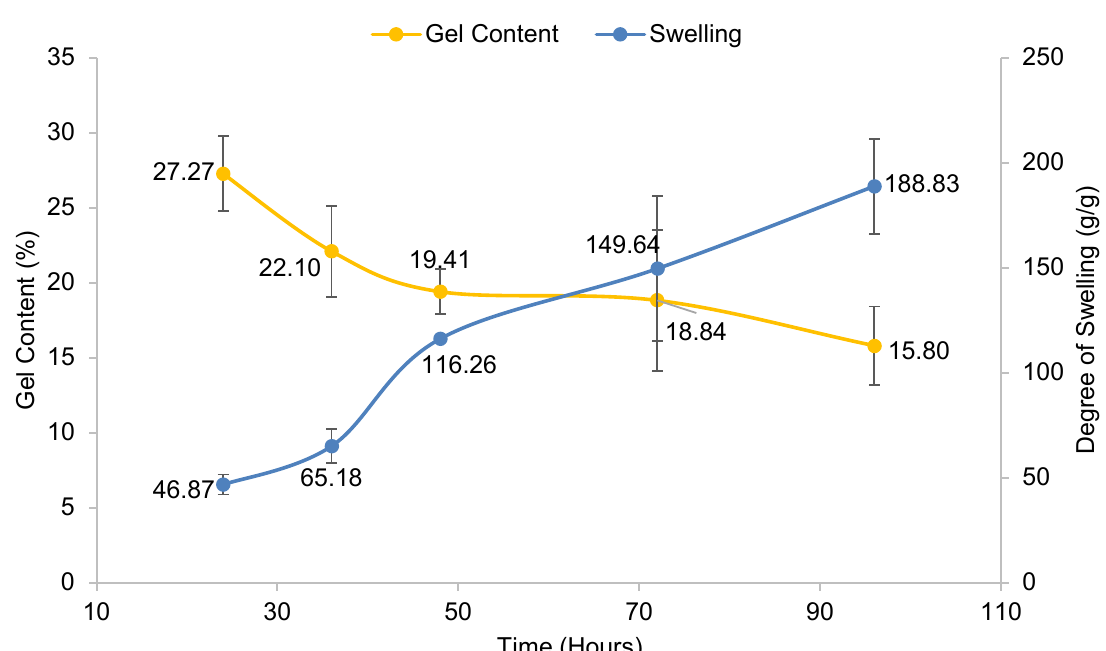
Figure 6. Effect of reaction time on gel content and degree of swelling of CMC hydrogel. Error bar indicates the standard deviation of uncertainty. Polymers 2021 , 13 , x FOR PEER REVIEW